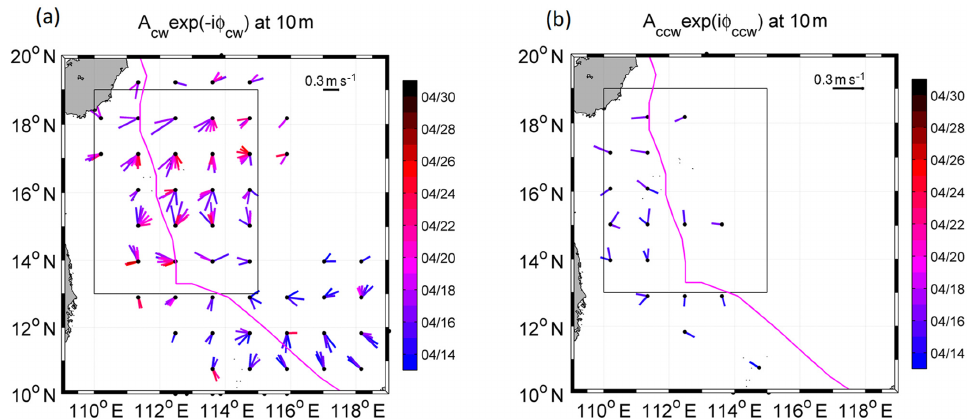
Figure 5. Time series, represented by colour bar, of daily (a) clockwise and (b) counter-clockwise rotary current vectors from 14 to 30 April during different stages of the TC forcing, signifying the response of the current to the local wind rotation. For the clockwise (counter- clockwise) component, only currents with a magnitude larger than 0.2 (0.05)ms − 1 are shown. The black box represents the forced region.